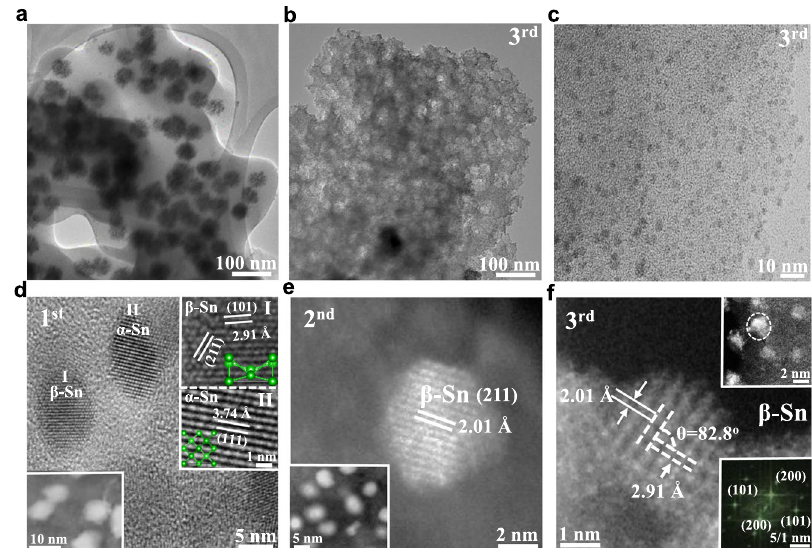
Fig. 2 TEM images. a TEM image of the SnO 2 nanoparticles embedded within the carbon matrix (amorphous carbon fl ake); b low- and c high-magni fi ed TEM images of the representative third Sn@C. d HRTEM image of fi rst Sn@C, the lower left inset showing the HADDF-STEM image and the upper right inset showing the enlarged HRTEM images collected from area I and II. e HAADF-STEM image of second Sn@C, the lower left inset showing the low- magni fi cation HAADF-STEM image. f HAADF-STEM image of third Sn@C, the upper right inset showing the low-magni fi cation HAADF-STEM image and the lower right inset presenting the fast Fourier transformed (FFT)